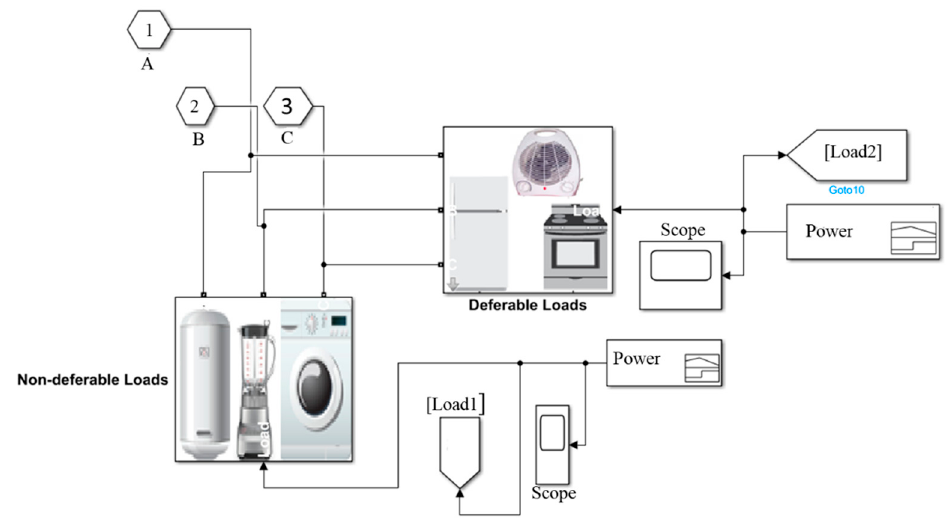
Figure 3. Simulink model of deferrable and non-deferrable loads (image sources adapted from [49]).